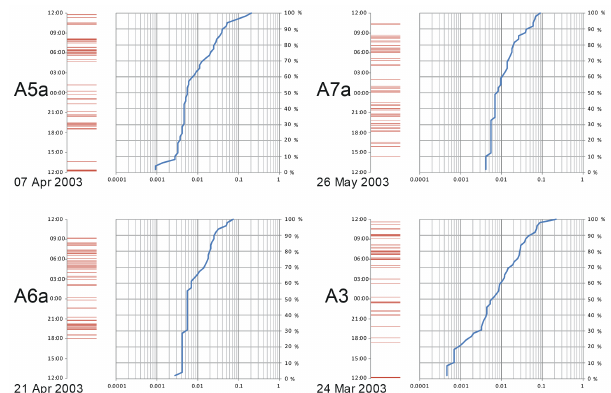
Figure 13. Times of the 50 largest local maxima of the average temperature of all the sensors on AIII bar (left), and the empirical cumulative distribution function of their interevent times, in units of fractions of a day (right) observed in the A5a, A7a, A6a, and A3 experiments. Time increases when going up.